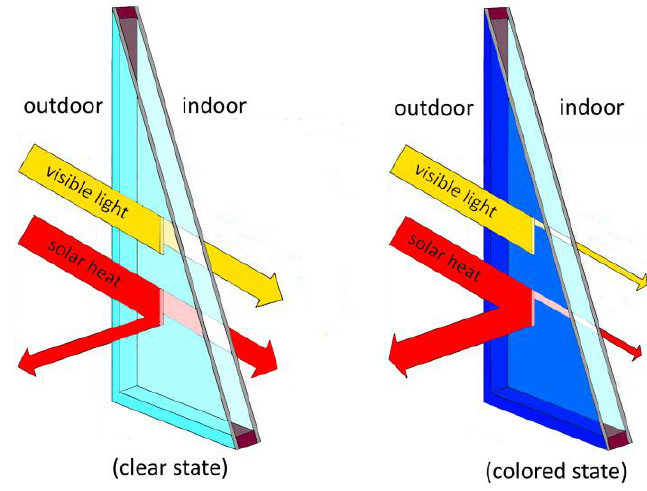
Figure 1. Typical smart windows operating modes.